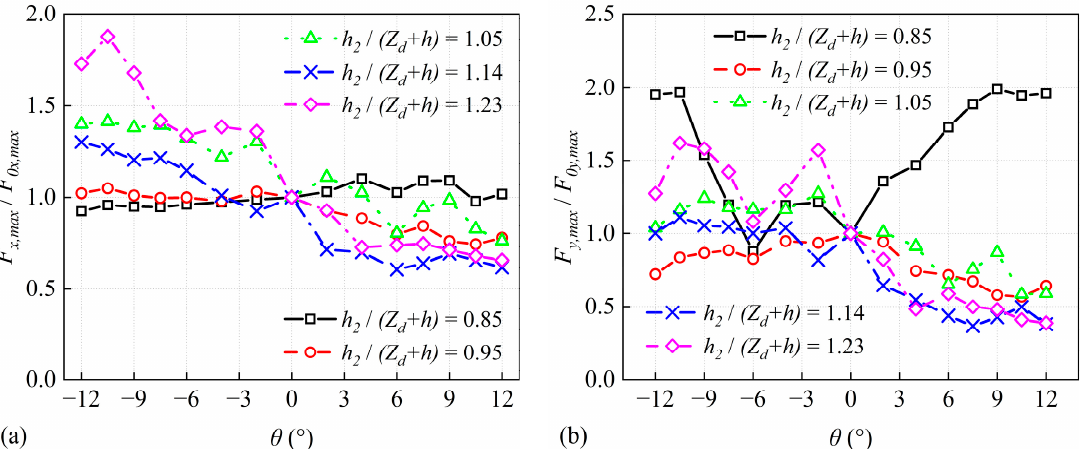
Figure 16. Relative tsunami force when ( a ) horizontal and ( b ) vertical during the impact stage ( h 0 = 0.1 m, Z d = 0.2 m).